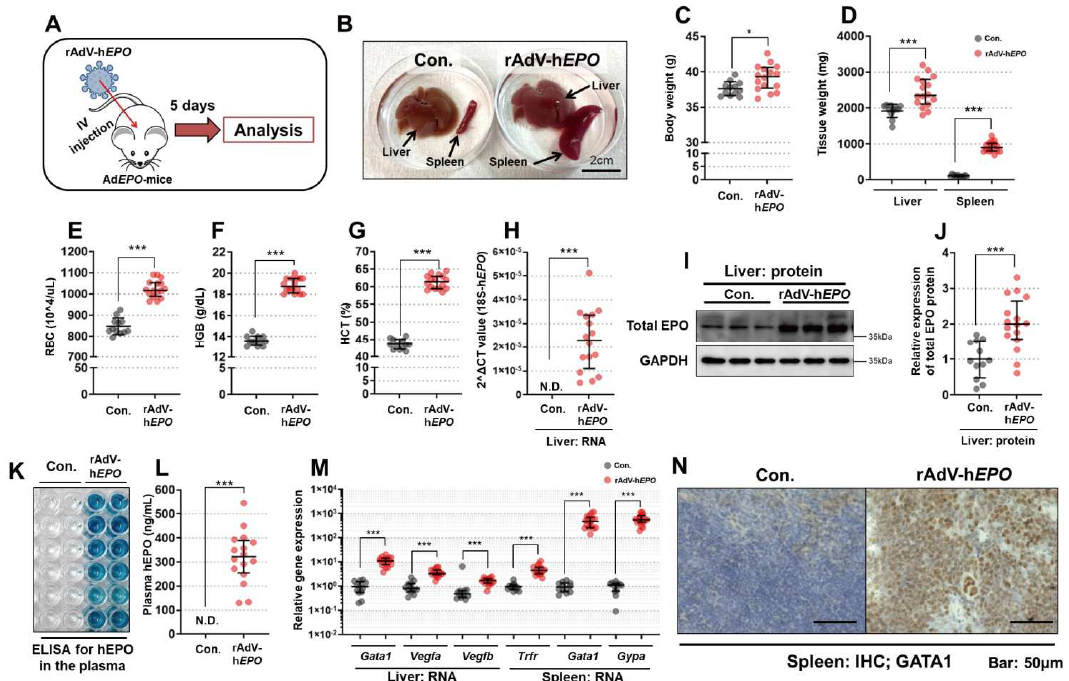
Figure 1. Establishment of a gene-doping model using rAdV-h EPO . The phenotypes and parameters related to hematopoiesis were assessed in the Con. ( n = 12) and rAdV-hEPO ( n = 15) groups. ( A ) An overview of the experiment, ( B ) a photograph of the liver and spleen of a representative mouse, ( C ) body weight of the mice, ( D ) liver and spleen weight, ( E ) RBC count (10 4 /µL), ( F ) Hgb level (g/dL), ( G ) HCT (%), ( H ) expression of the h EPO gene in the liver, ( I ) representative images of total EPO and GAPDH on WB analysis of liver specimens, ( J ) quantification of the band intensity on WB, ( K ) a representative image of the actual reaction plate of ELISA for the hEPO protein, which was performed as duplicate measurements of 6 samples, ( L ) results of quantification with ELISA, ( M ) analysis of the expression levels of genes encoding hematopoietic markers in the liver and spleen, ( N ) micrographs of GATA1-stained spleen sections evaluated using IHC. N.D.: not detected. * p < 0.05, *** p < 0.001.